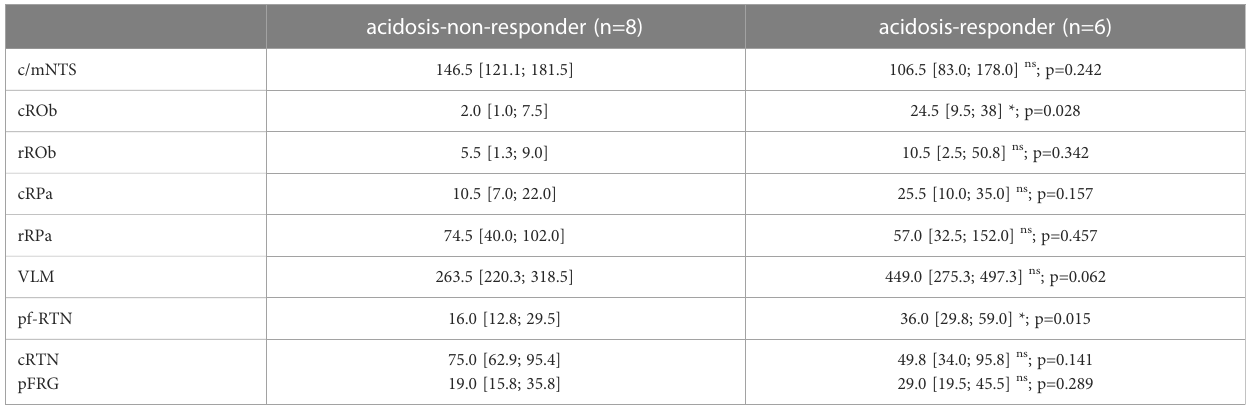
TABLE 1 c-FOS-positive number of cells in respiratory areas of the medulla oblongata in Phox2b mutant preparations under etonogestrel. acidosis-non-responder